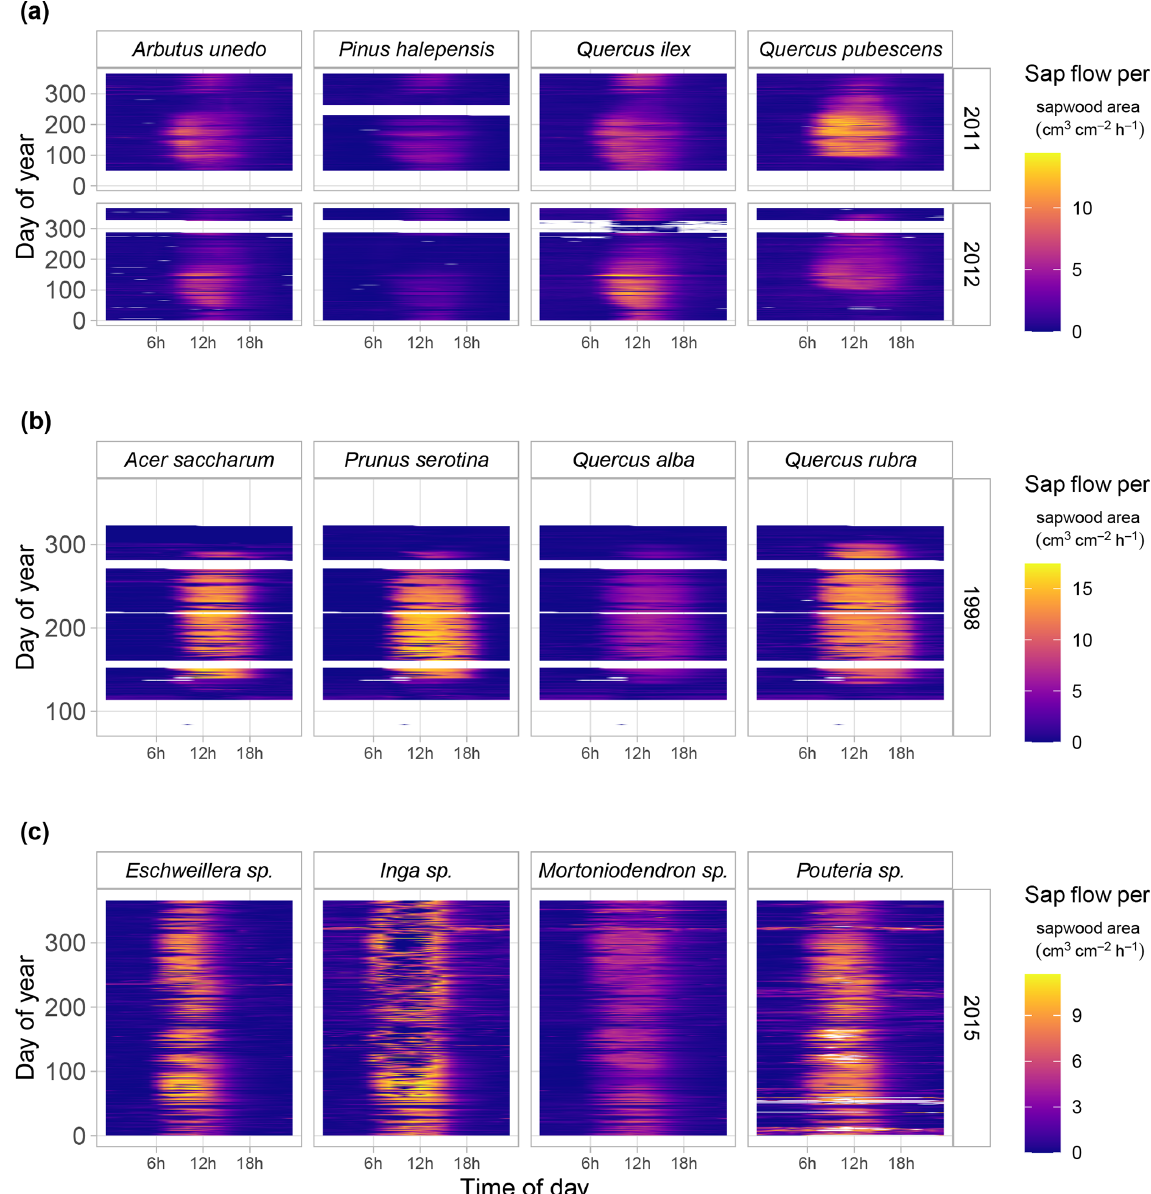
Figure 7. Fingerprint plots showing hourly sap flow per unit sapwood area (colour scale) as a function of hour of day ( x axis) and day of year ( y axis) for a selection of SAPFLUXNET sites with at least four co-occurring species. Panel (a) shows data from a woodland/shrubland forest in NE Spain (ESP_CAN) for an average (2011) and a dry (2012) year. Panel (b) shows data for a mesic temperate forest (USA_WVF), and panel (c) shows data for a tropical forest (CRI_TAM_TOW). For the latter site, only 4 of the 17 measured species are shown, and some of them were only identified at the genus